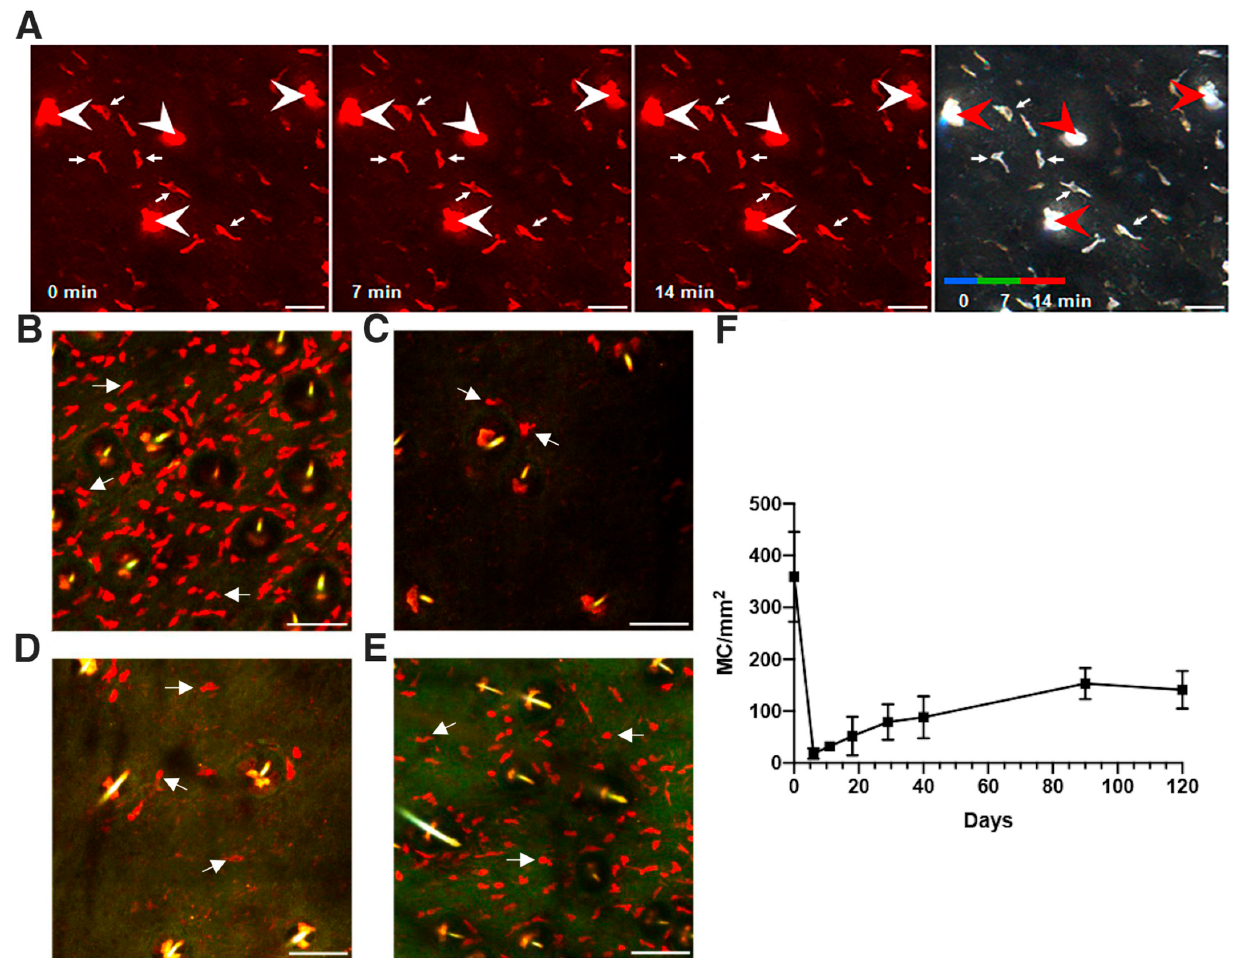
Figure 1. Mast cells are sessile and are slowly replenished after conditional ablation in the ear skin of RMB mice. ( A ) Visualization of tdT + MCs and their dynamics in the ear skin of RMB mice by intravital confocal microscopy. Single optical sections of 1.5 µ m thickness are represented choosing a mid-position with maximal number of MCs in the dermis, and were obtained at indicated time points from the 4D image stacks of the ear-skin monitored here for 14 min. Hair follicles and associated sebaceous glands are pointed with large arrowheads, whereas MCs pointed with arrows appear as thin elongated objects. Three sequential time points (0 min, 7 min and 14 min) were merged in an overlay RGB image on the right panel. The resulting white color indicate that MCs are sessile over this time frame. ( B – E ) Maximum Z projections of 3D stacks (20–30 sections over a total of 30–45 µ m thickness) were performed to visualize the kinetics of repopulation of tdT + MCs in the ear skin after conditional ablation following DT i.p. injection. ( B ) Before DT injection, tdT + MCs form an array of mostly elongated cells at the steady state. ( C ) 6 days after DT injection, very few tdT + MCs are present, while ( D ) sparse tdT + MCs are found 11 days post DT injections. ( E ) Numerous tdT + MCs are found 3 months after conditional ablation of MCs. ( F ) Time course of MC repopulation after conditional ablation. MCs were enumerated in the skin of RMB mice prior (day 0) and after indicated times of DT treatment. Each quantification was performed on Z projection images as in B-E in at least three independent fields of over 400 × 400 µm from two to four mice and expressed as total MC numbers per mm 2 . Arrows in ( B – E ) point to MCs. Scale bars ( A ) 30 µm and ( B – E ) 100 µm.